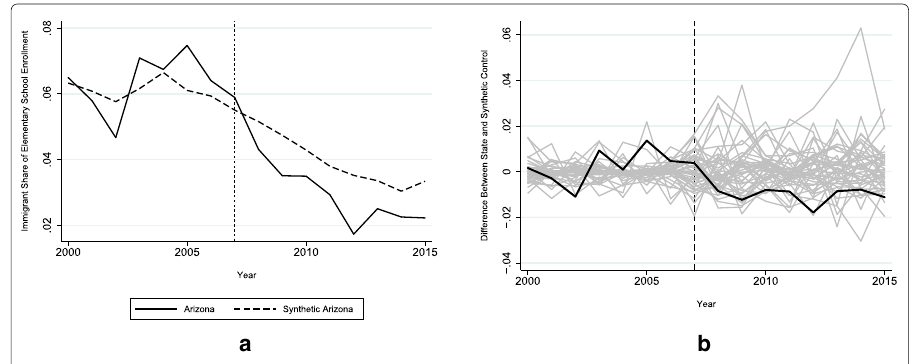
a b Fig. 4 LAWA and share of immigrants in elementary school. a Share of immigrants. b Permutation test